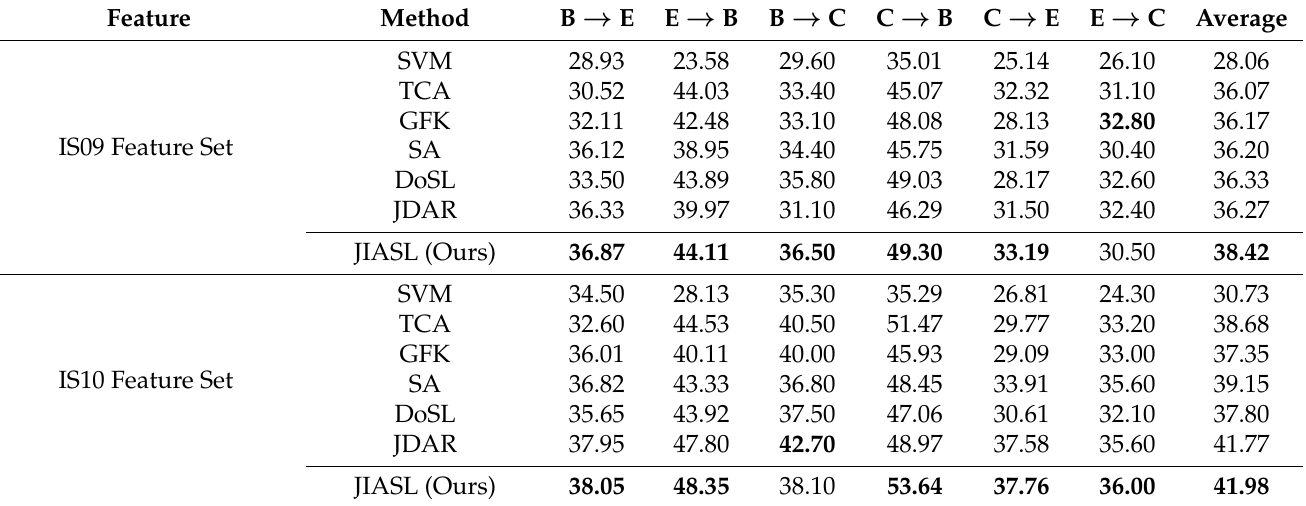
Table 3. The experimental results in terms of UAR (%) for six designed cross-corpus SER tasks. The best result in each task is highlighted in